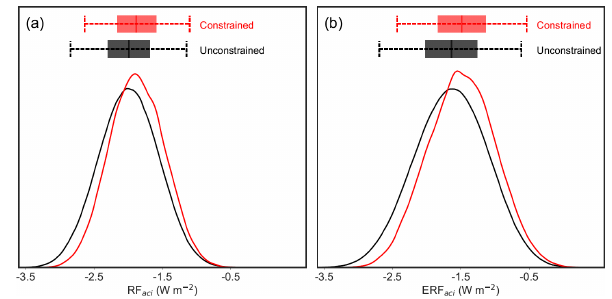
Figure 4. Probability distributions of (a) RF aci and (b) ERF aci . The distributions of the unconstrained sample of 1 million model vari- ants from statistical emulators of each PPE are in black. Red lines show the distributions after constraint using ACE-SPACE mea- surements (around 3% of the unconstrained sample). The 25th, 50th, and 75th percentiles of each sample are shown as shaded boxes, and dashed lines span the percentiles 2.5 and